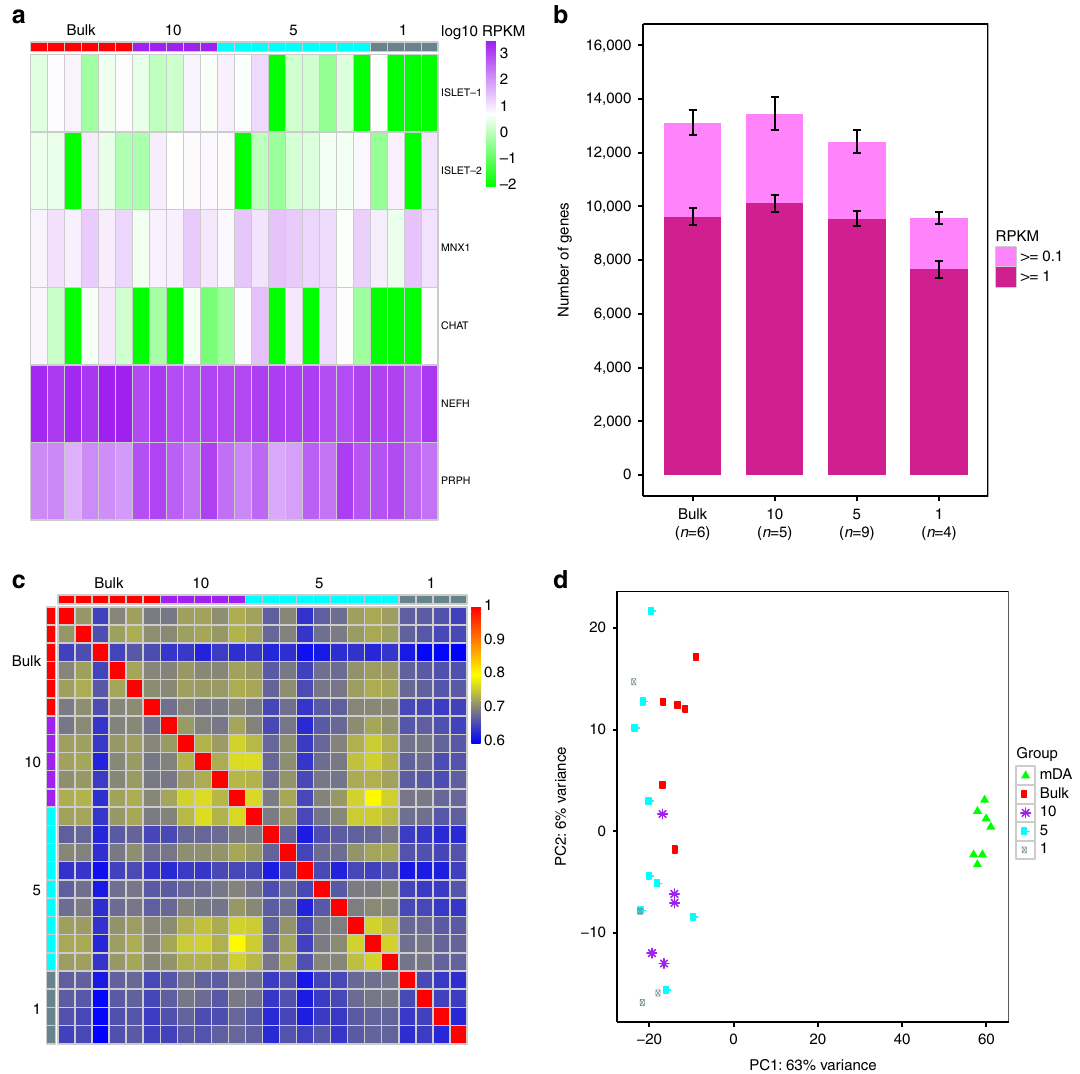
Figure 5 | LCM-seq is applicable to single human MNs isolated from post-mortem tissues. ( a ) Human MNs expressed the MN-specific markers ISLET-1/2 , MNX1 , CHAT , NEFH and PRPH . ( b ) Mean number of genes detected in the distinct groups of different cell numbers; bulk (179.7 ± 30.8 cells), 10, 5 and 1 MN (displayed as mean ± s.e.m.). ( c ) Gene expression correlation for bulk, 10, 5 and 1 cell samples (Spearman’s correlation; genes expressed at Z 1 RPKM in at least one sample were used). ( d ) PCA of bulk, 10, 5 and 1 MN groups and bulk mDA neurons, based on the top 500 variable